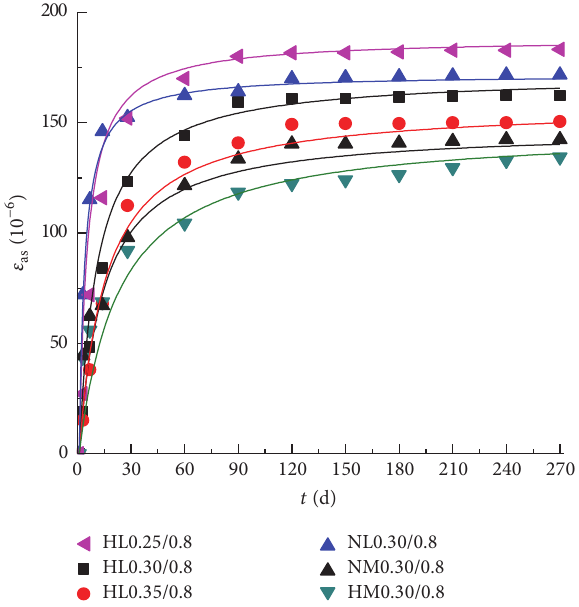
Figure 4: Autogenous shrinkage of